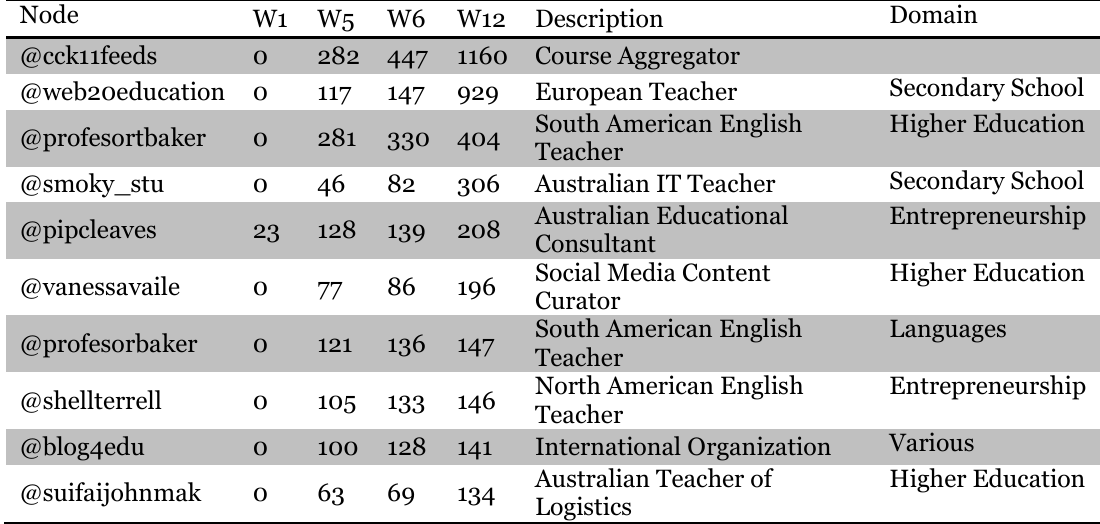
Table 1 Distribution of Weighted Output Degree for Weeks 1, 5, 6, and 12 with the Demographic Data for the Top 10 Ranked Nodes within the Last Week Node W1 W5 W6 W12